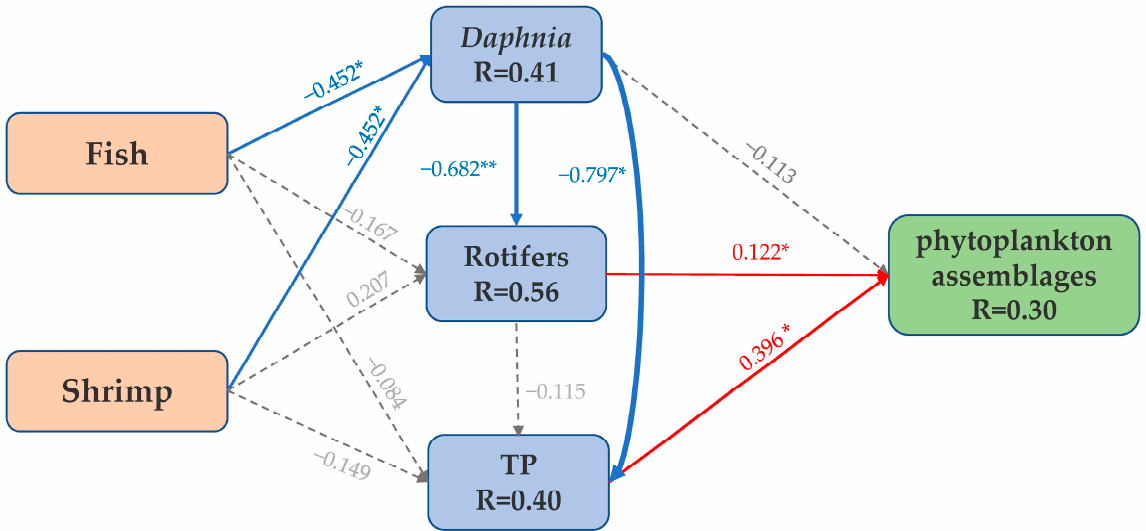
Figure 6. Structural Equation Model (SEM) of influencing factors in relation to changes in phyto- plankton assemblages. Red solid lines represent positive correlations that passed the significance test, blue solid lines represent negative correlations that passed the significance test, gray dashed lines represent those that did not pass the significance test. ∗ : p < 0.05; ∗∗ : p < 0.01)